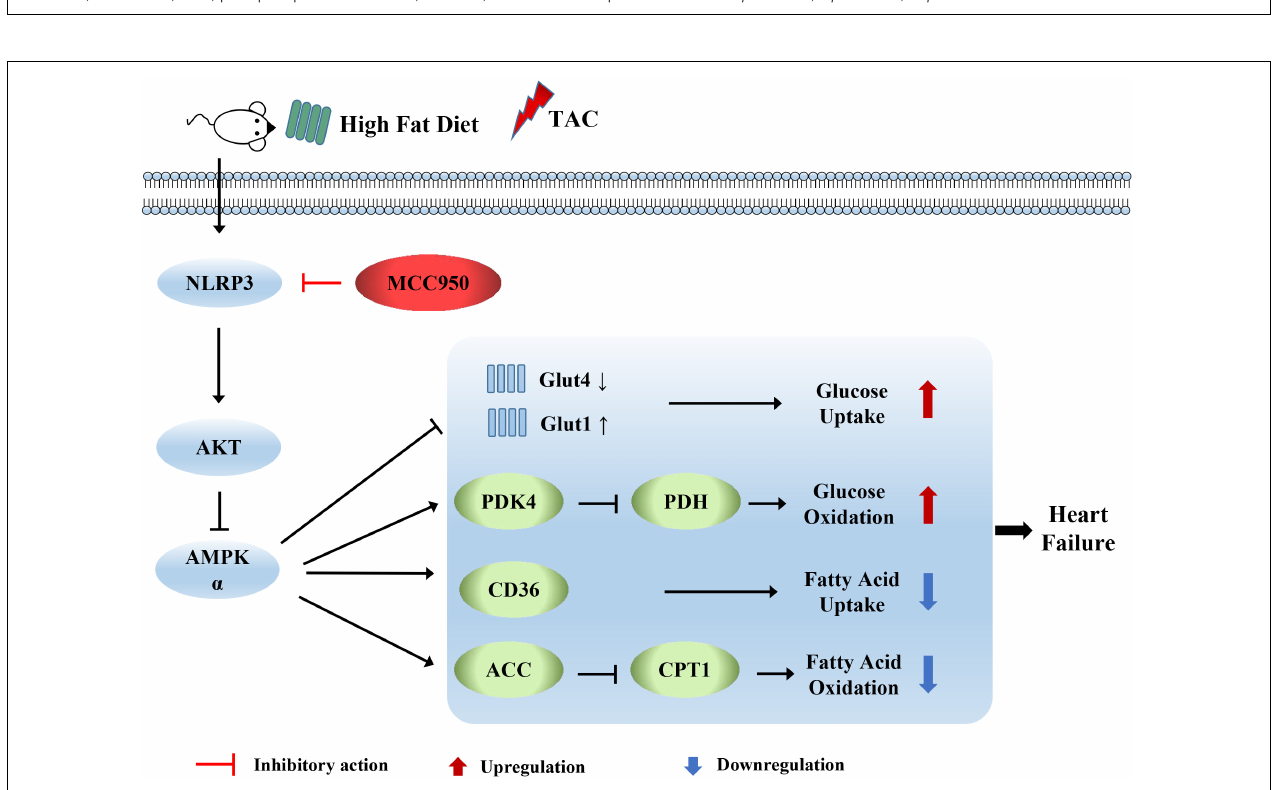
FIGURE 9 | Diagram depicting the mechanism by which MCC950 regulates cardiometabolism in obese mice with heart failure.